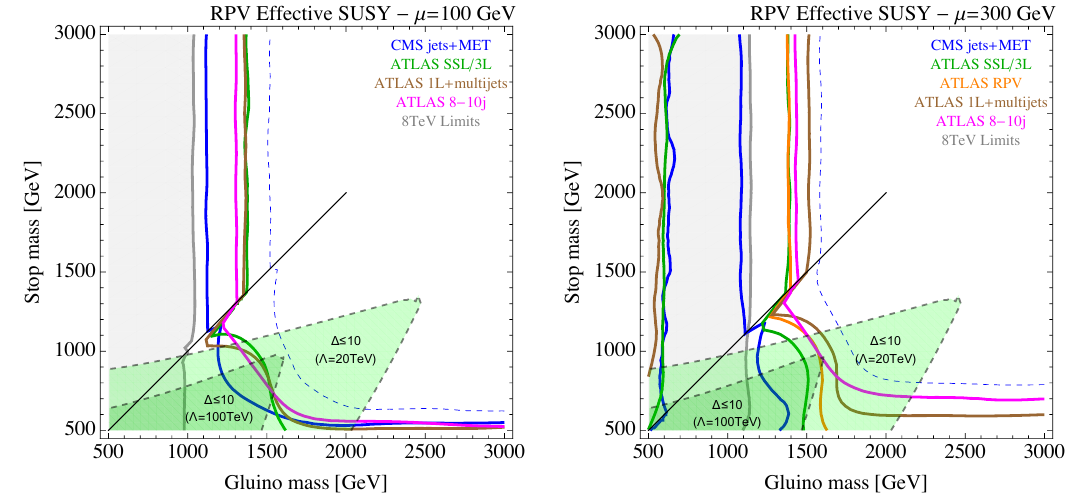
Figure 5 . Limits on the E(cid:11)ective RPV SUSY model with (cid:22) = 100 GeV (left) and 300 GeV (right) as a function of the gluino and the stops and left-handed sbottom masses. All other conventions are as in (cid:12)gure